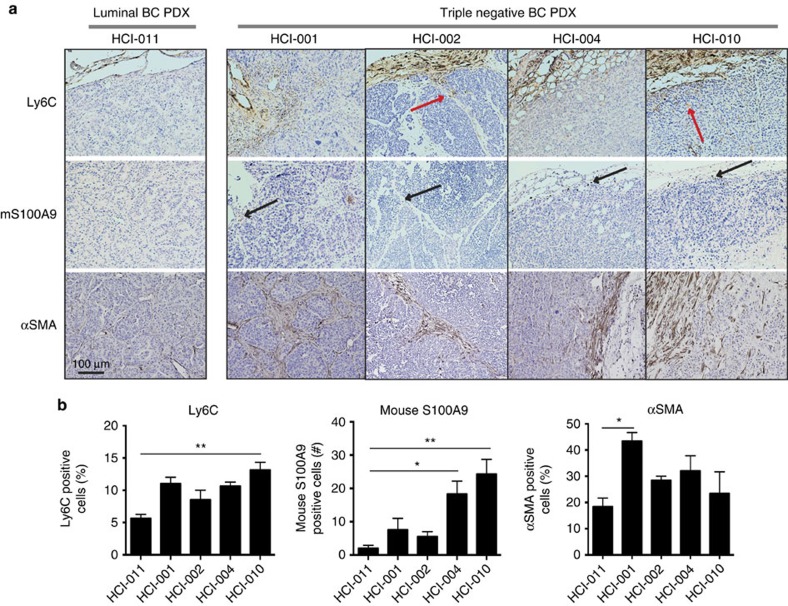
IHC of PDXs.PDXs from TN breast tumours show increased myeloid cell infiltration, expression of S100A9 and activated fibroblasts. PDXs from one luminal (HCI-011) and four TN (HCI-001, HCI-002, HCI-004 and HCI-010) breast cancers grown in non-obese diabetic-severe combined immunodeficiency (NOD-SCID) mice were analysed for presence of monocytes (Ly6C mouse specific), expression of mouse S100A9 (mouse specific) and activated fibroblast (αSMA; recognizes human and mouse). (a) Ly6C positive cells were present in the tumour borders, with some cells infiltrating the stromal areas in particular (red arrows). Mouse S100A9 positive cells were present in the tumour borders and areas where myeloid cells were also present, and importantly mainly in the TN PDX grafts (black arrows). αSMA was expressed in the stromal areas of the PDX grafts, representing activated fibroblasts. (b) Quantitation of the immunohistochemical stains as presented by the histograms showing the mean value for each protein. For each PDX graft, 2–4 sections were stained and scored (N=3–6). For αSMA and Ly6C the percentage (%) of positive cells was scored and for mouse S100A9 the numbers (n) of infiltrating cells expressing S100A9 was scored. A significantly higher level of Ly6C positive cells (left), of mouse S100A9 positive cells (center) and of αSMA (right) was seen in the TN PDX grafts as compared with the luminal PDX graft. *=P<0.05 ***=P<0.001. ANOVA non-parametric Kruskal–Wallis test. N=(3–6). Error bars indicate s.e.m.